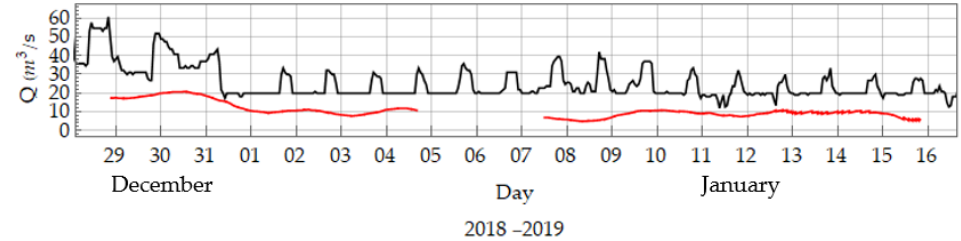
Figure 7. Comparison of the freshwater release from the Yaguchi Station (black) and the residual discharge as estimated using FAT (red).